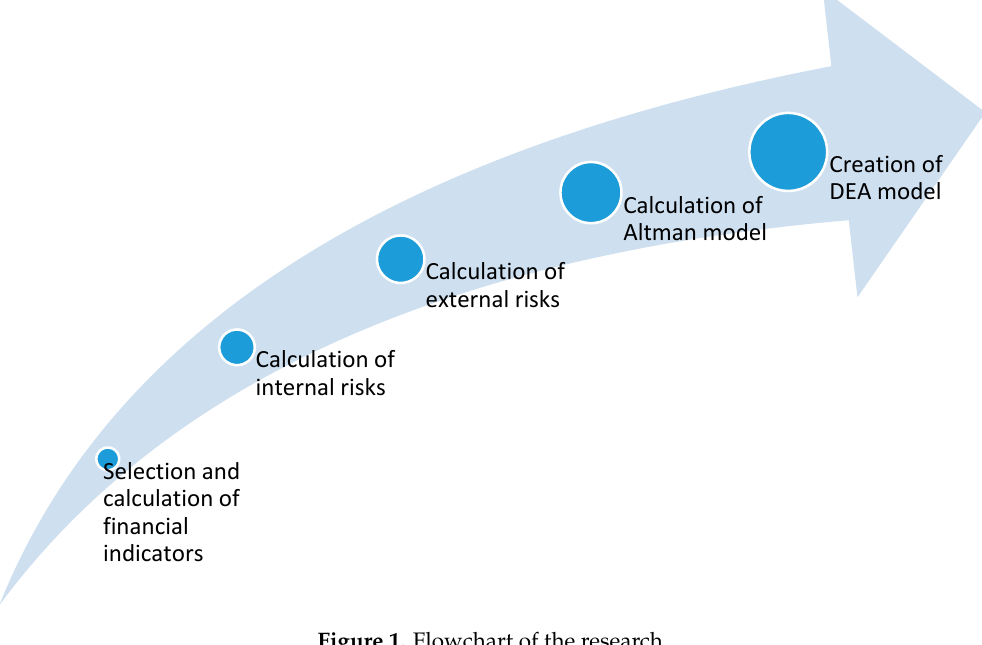
Figure 1. Flowchart of the research.